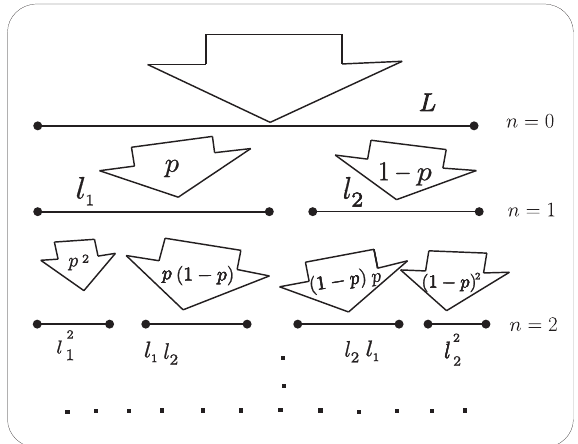
Figure 1. Two-scale weighted Cantor set model for asymmetric so- lar wind turbulence (Macek, 2007).